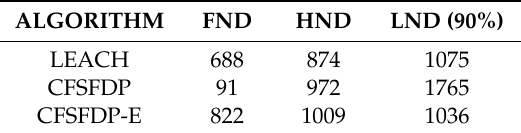
Table 5. Network lifetime comparison of LEACH, CFSFDP and